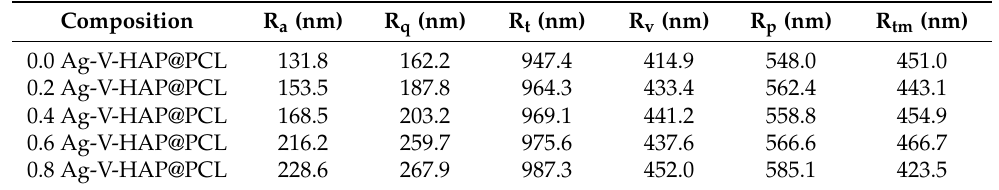
Table 4. Surface roughness parameters of Ag-V-HAP@PCL nanofiber with different silver content.